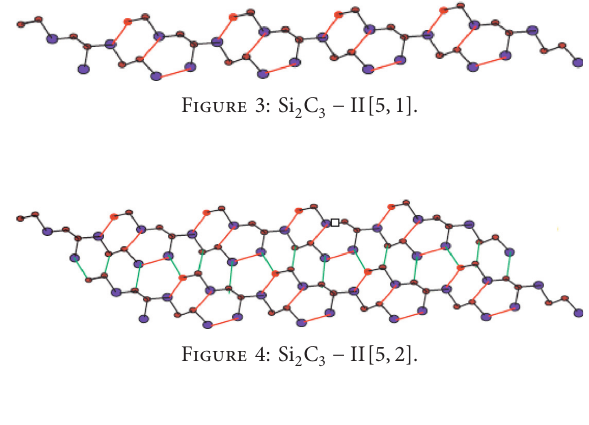
Table 1: Partition of E ( Si